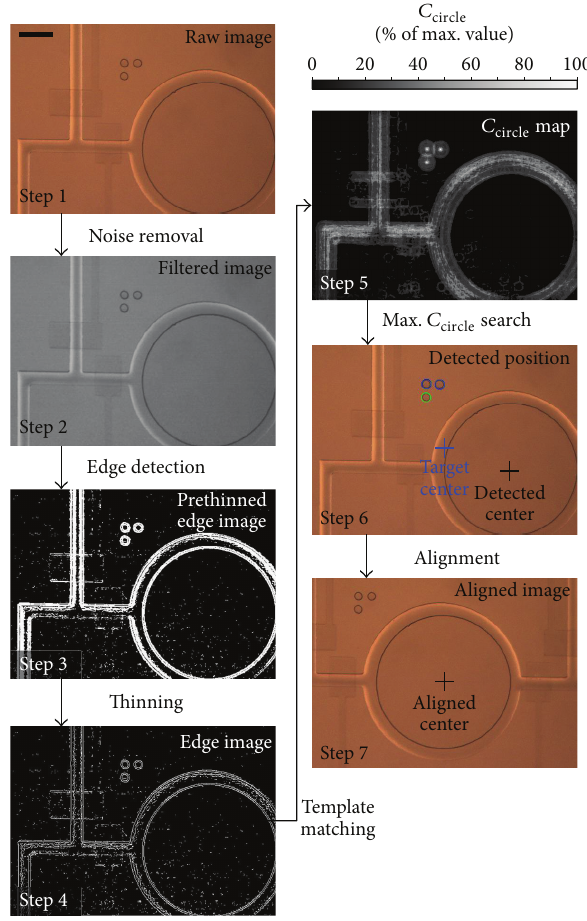
Figure 5: Different steps during the automated chamber alignment procedures. Scale bar: 250 𝜇